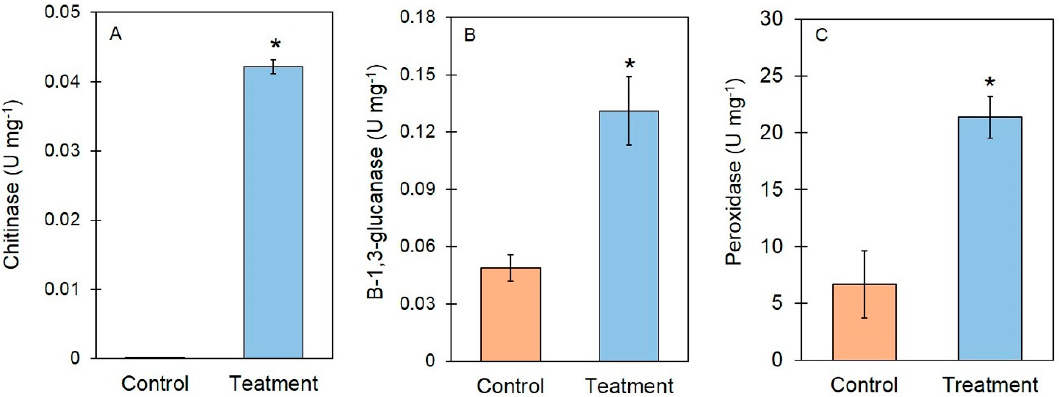
Figure 6. Enzyme activities of chitinase ( A ), β -1,3-glucanase ( B ), and peroxidase ( C ) between the control and VOC-treated A . thaliana . Asterisks indicate statistically significant differences (* p < 0.05) using the Student’s t -test.